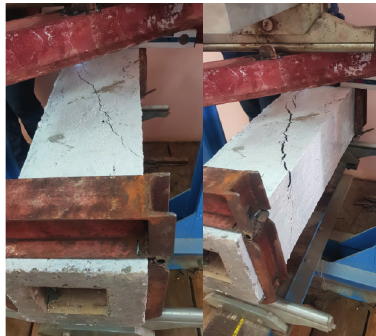
Figure 6: Crack pattern of beam BM0.